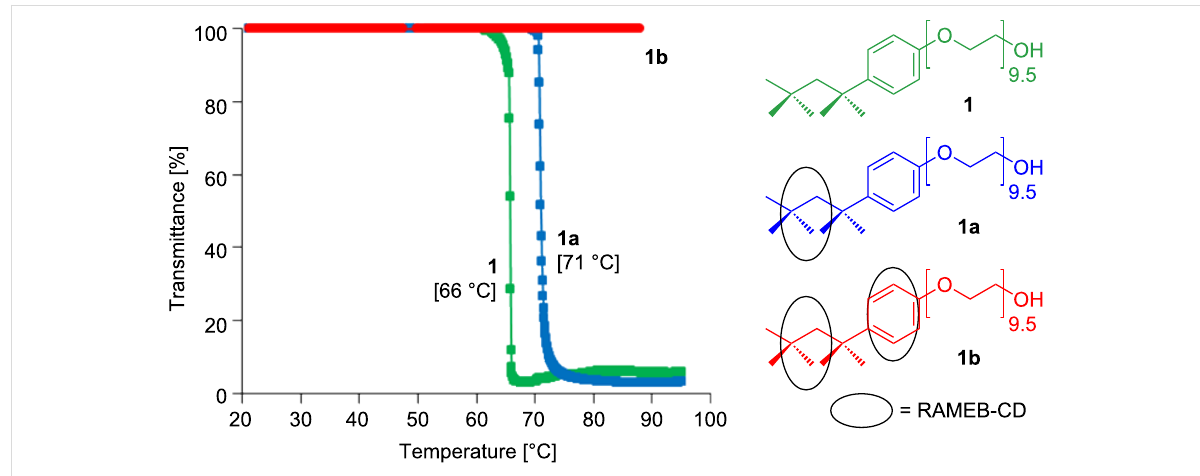
Figure 2: Solubility in water of 0.2 wt % Triton ® X-100 ( 1 ) and its different assumed complexes with RAMEB-CD ( 1a and 1b ) according to the trans- parence measurement.